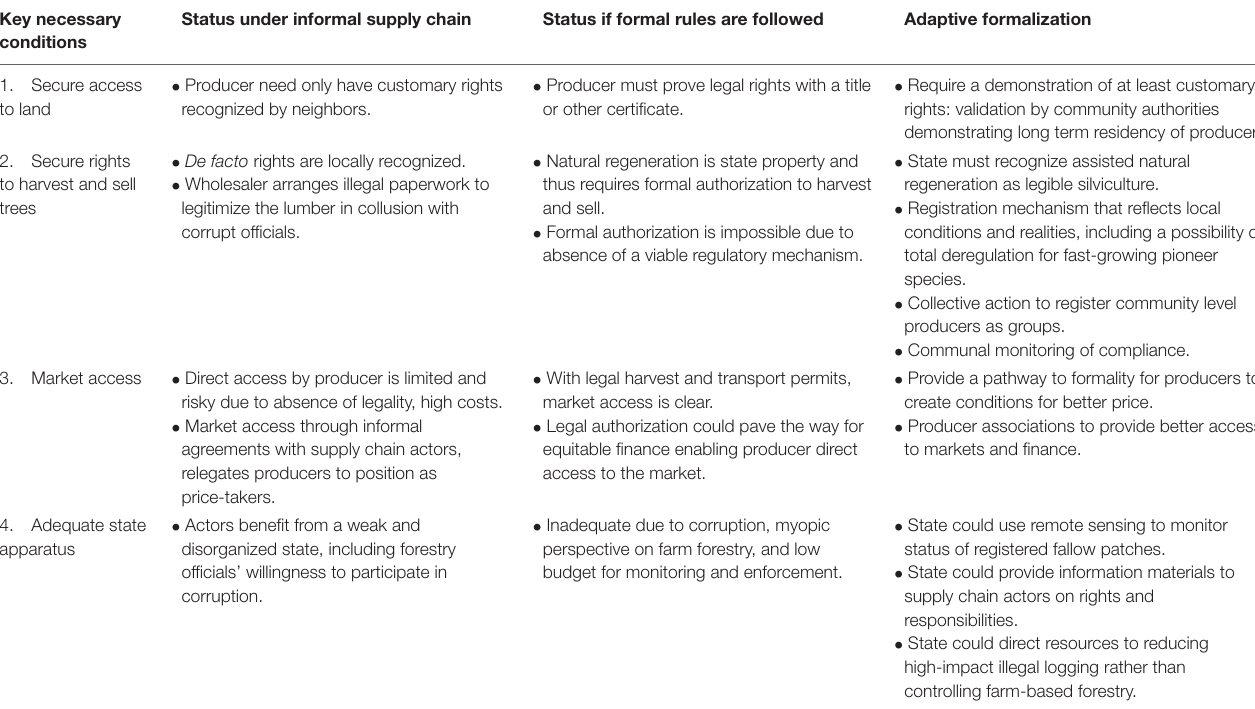
TABLE 2 | Conditions for smallholders to commercialize trees from their agricultural fallows, evaluation related to three scenarios: the current informal supply chain, under current regulatory framework, and under an adaptive formalization process. Key necessary Status under informal supply conditions